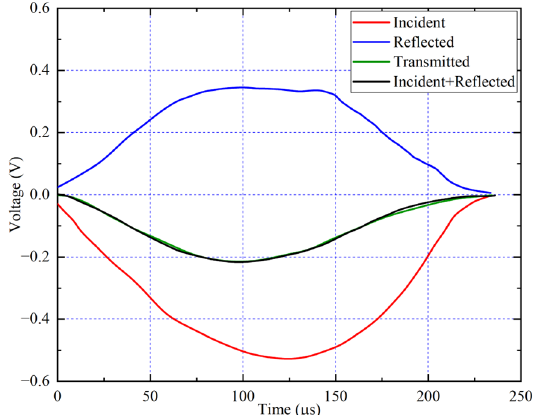
Figure 6. Verification of test stress uniformity hypothesis.